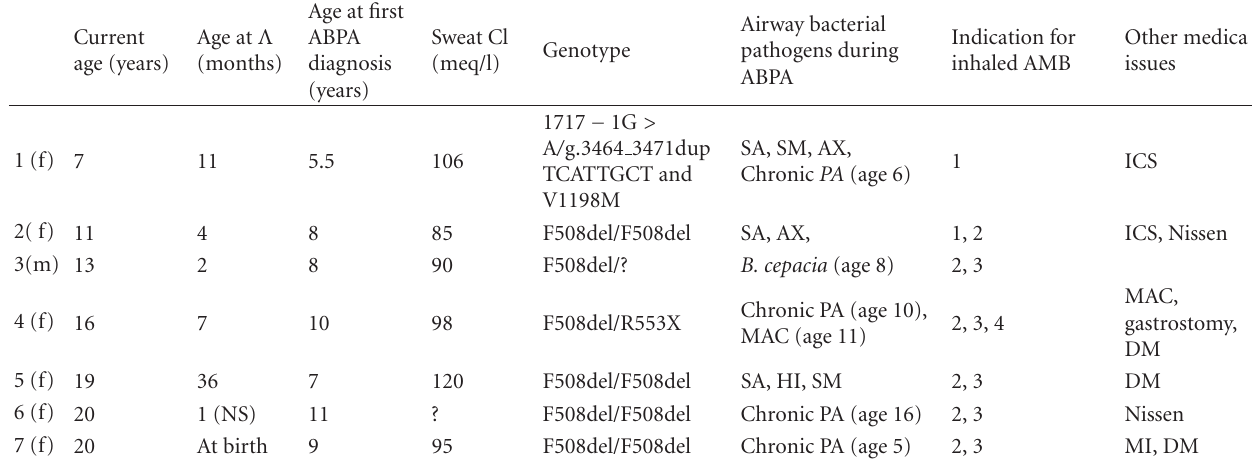
Table 2: Di ff erent formulation of amphotericin B. Formul-